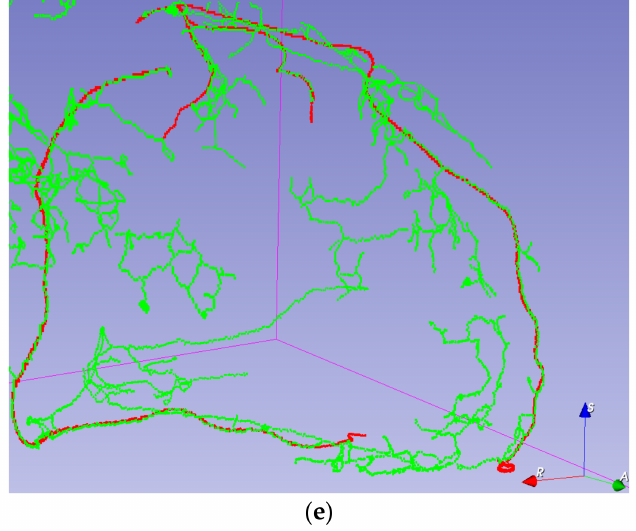
Figure A3. Visual validation for different parameter configurations. The ground truth centerline is depicted in red. The segmentation (after thinning) is seen in green for ( a ) 128 × 128 × 96, batch size 1, reduction 1, only patches with ground truth; ( b ) 128 × 128 × 128, batch size 2, reduction 2, only patches with ground truth; ( c ) 256 × 256 × 128, batch size 1, reduction 2; ( d ) 320 × 320 × 64, batch size 1, reduction 4; and ( e ) 384 × 384 × 48, batch size 1, reduction